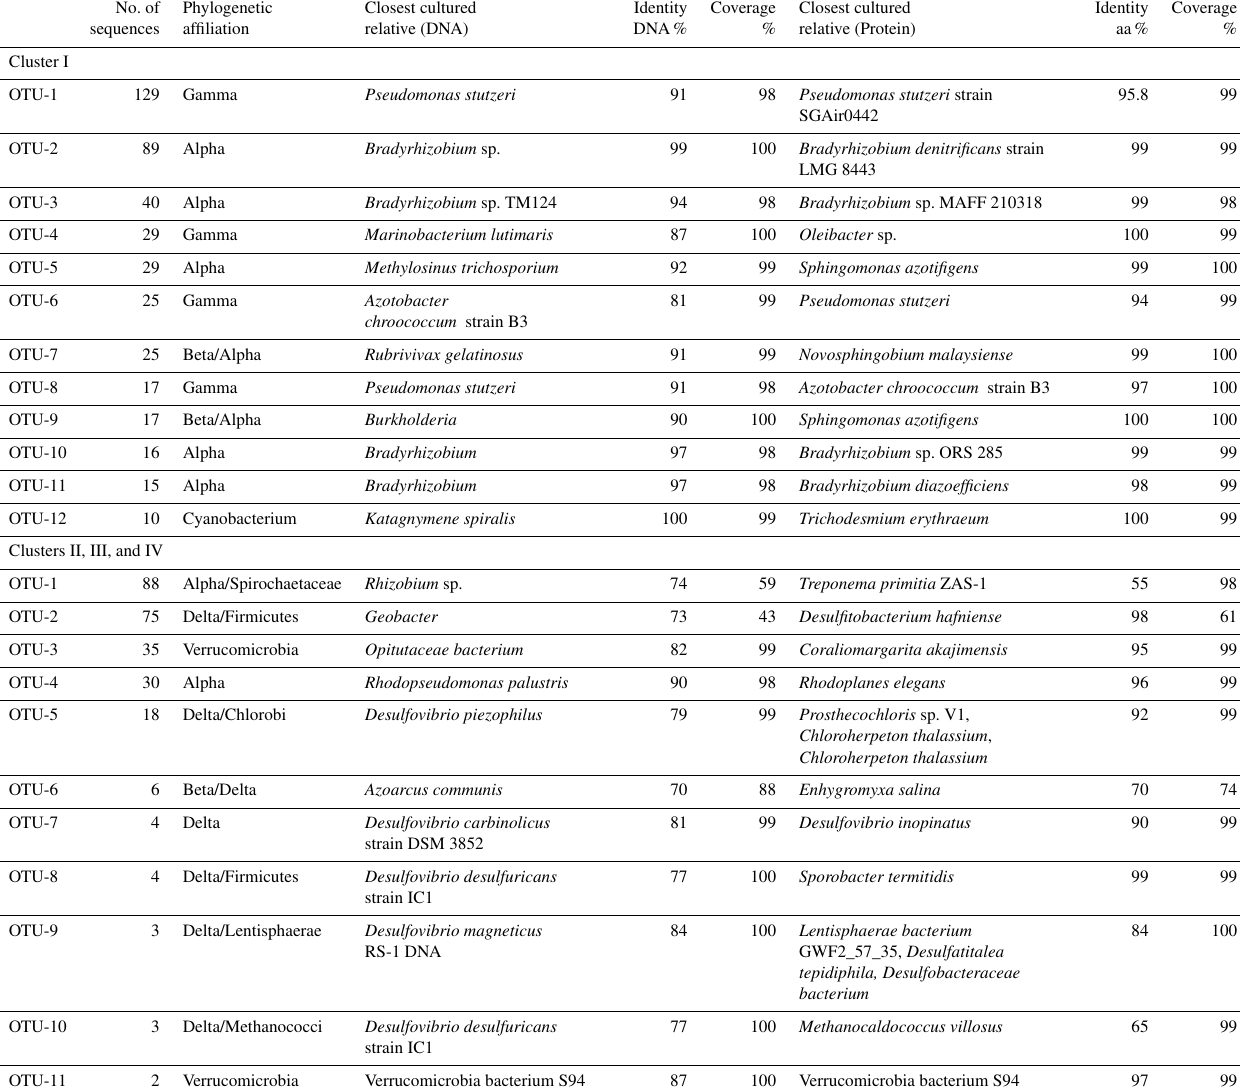
Table 3. OTU identities. OTU identities for both clusters. Cultivated species with closest nucleotide identity to the OTUs identified in the nifH clone libraries from three OMZ regions. Only the 12 most common OTUs (out of 41 total) are listed for Cluster I sequences, and the 11 most common (out of 18 total) are listed for the Cluster II, III, and IV